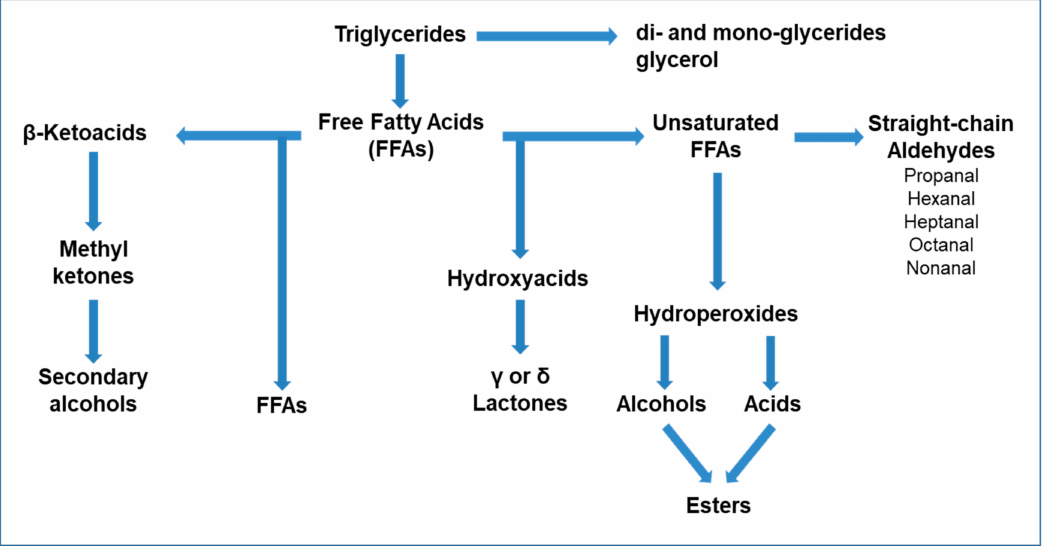
Figure 2. Schematic representation of free fatty acid (FFA) catabolism in cheese, modified from Bertuzzi et al.